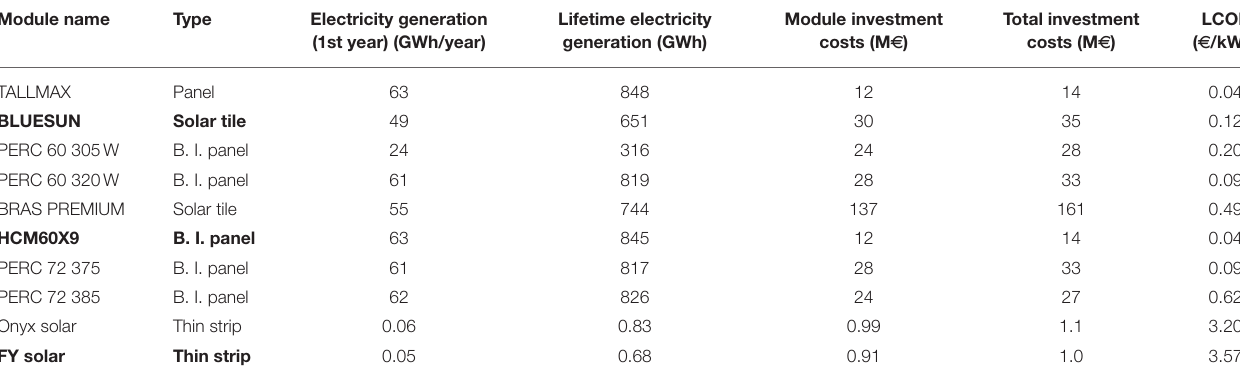
TABLE 6 | Electricity generation, investment costs, and LCOE of solar PV